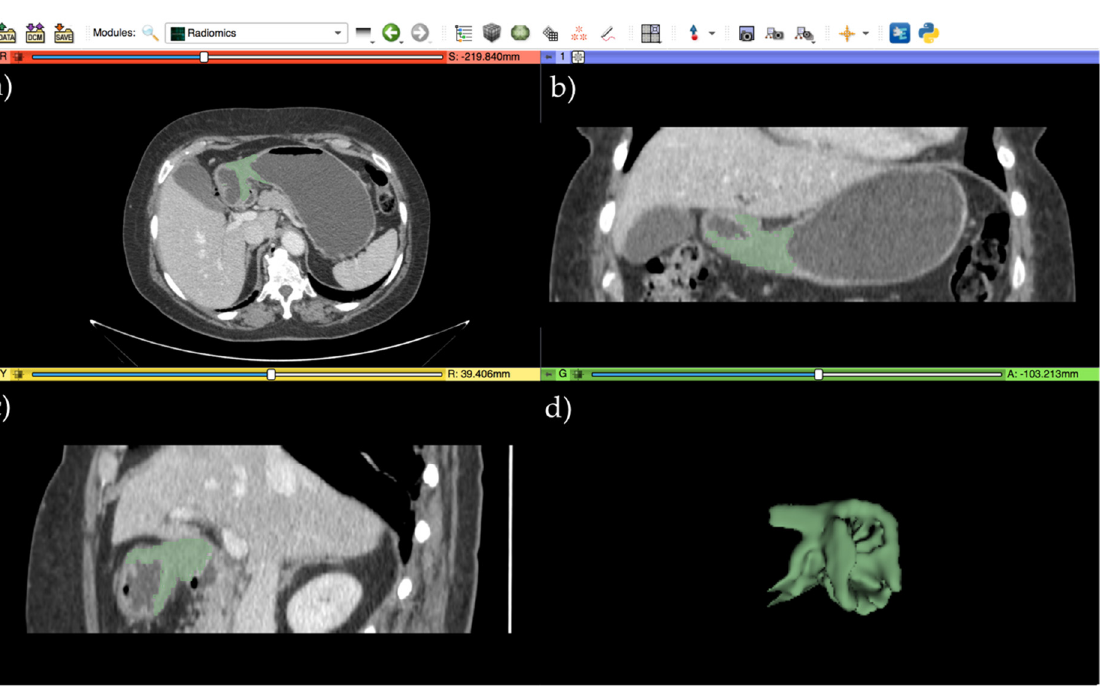
Figure 1. A volumetric manual segmentation performed with 3D Slicer software (version 4.10.2, http://www.slicer.org (accessed on 24 October 2020)) on a portal-venous phase CT scan of a 78-year-old woman with locally advanced gastric cancer after perioperative chemotherapy. ( a – c ) Axial, coronal, and sagittal plane views respectively. ( d ) The final 3D representation of the whole tumor segment, avoiding the surrounding healthy mucosa, gas, and perigastric